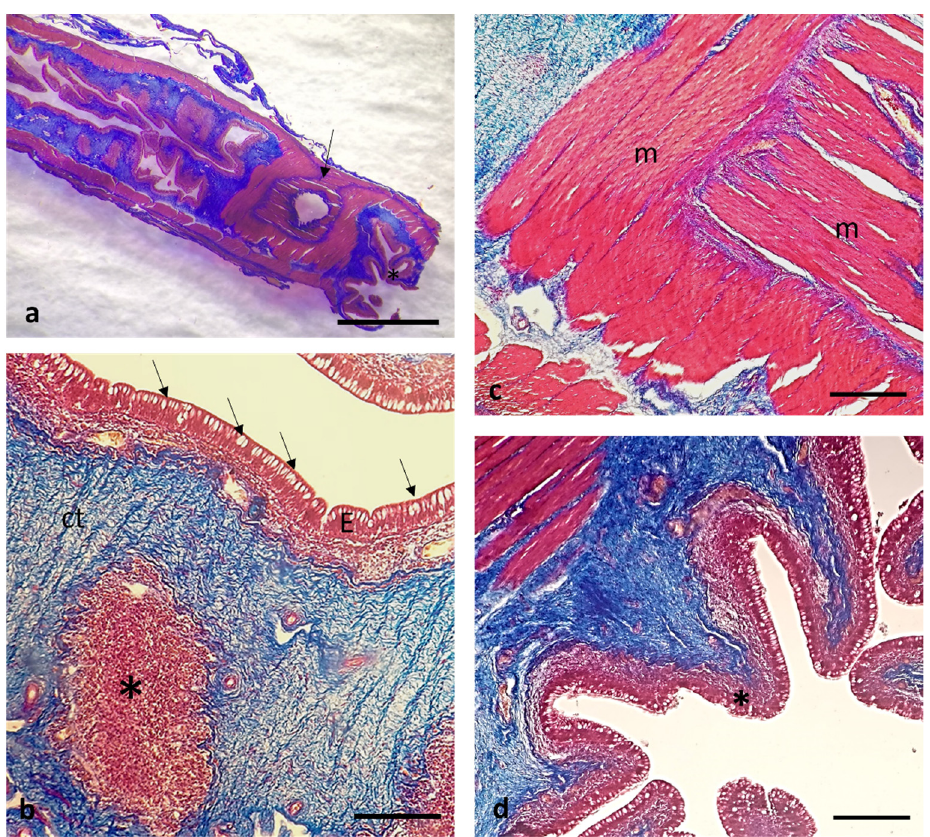
Figure 12. Masson Trichrome with Aniline Blue staining. ( a ) Stereomicrographs of the longitudinal section of the rectum: anal sphincter (arrow), anus (asterisk). ( b ) Micrograph of rectal mucosa: simple columnar epithelium (E), goblet cells (arrows), secondary lymphoid organs (asterisk) in the submucosa. ( c ) Muscular fibers (m) oriented in intertwined bundles forming an anal sphincter. ( d ) Micrograph of the anus (asterisk). Scale bar: 1 mm ( a ), 100 µ m ( b ), 50 µ m ( c , d ).